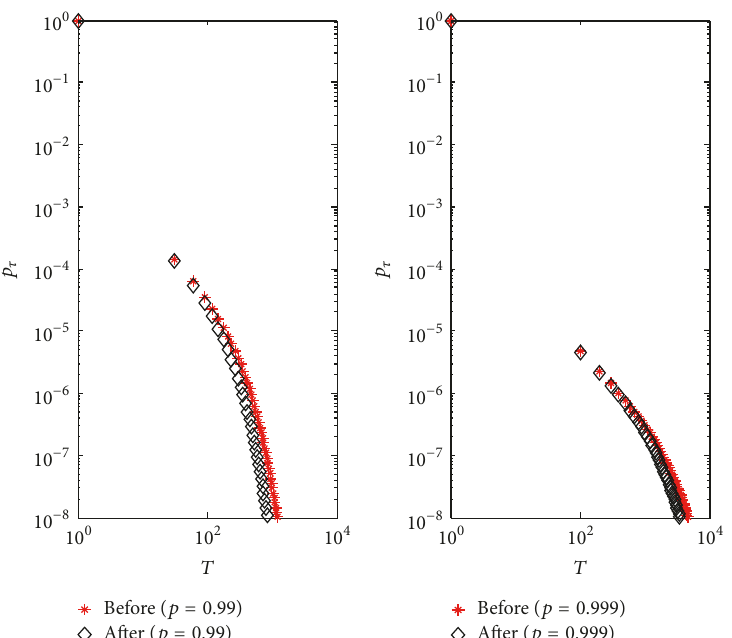
Figure 8: Harmful event waiting time probability distribution comparison chart ( 𝑝 = 0.99/0.999 ).